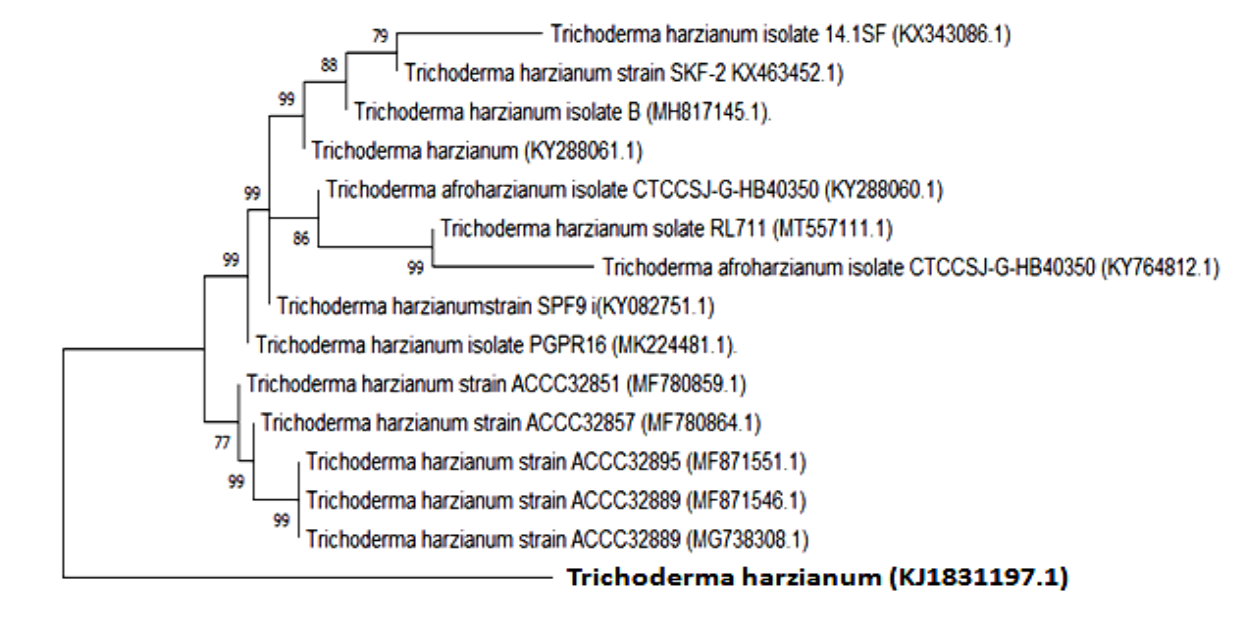
Figure 2. The phylogenetic tree shows the phyletic relationships among the T. harzianum (KJ831197.1) isolate and other eight matching homologous species and strains from the NCBI gene bank database. The DNA substitution model was the p-distance (nucleotide)method, and the phy- logenetic tree construction was depicted by the construct and test neighbor-joining tree model ac- cording to Saitou N. and Nei ’s (1987) NJ method.